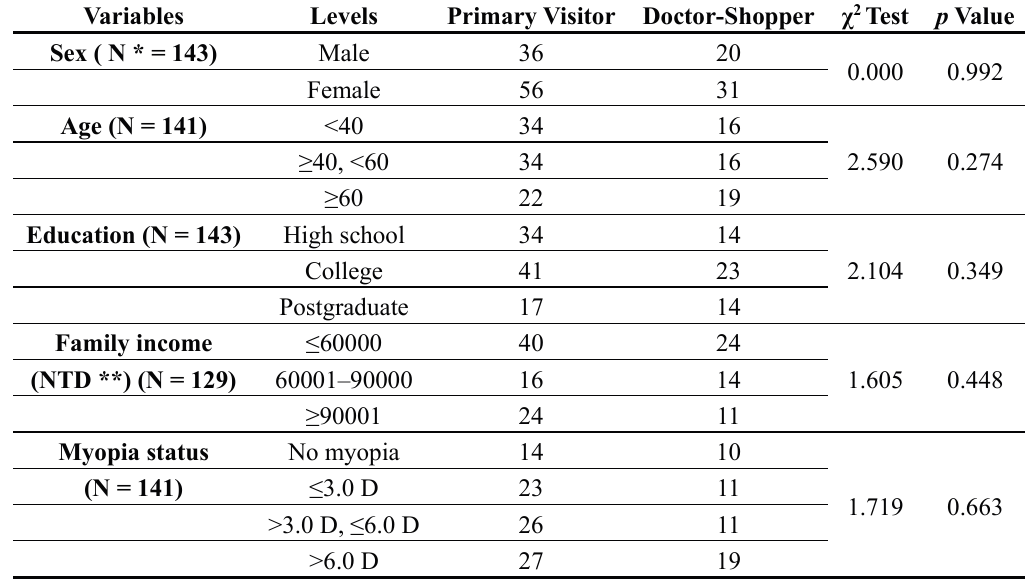
Table 1. Socio-demographic data.